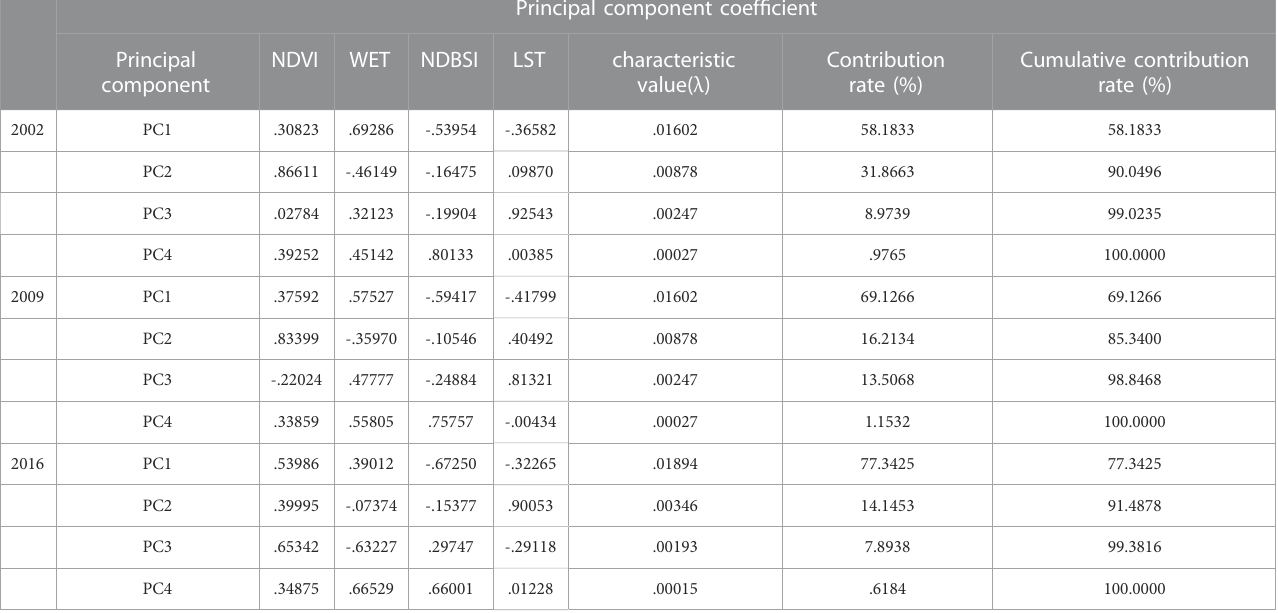
TABLE 1 Principal component analysis of each index.